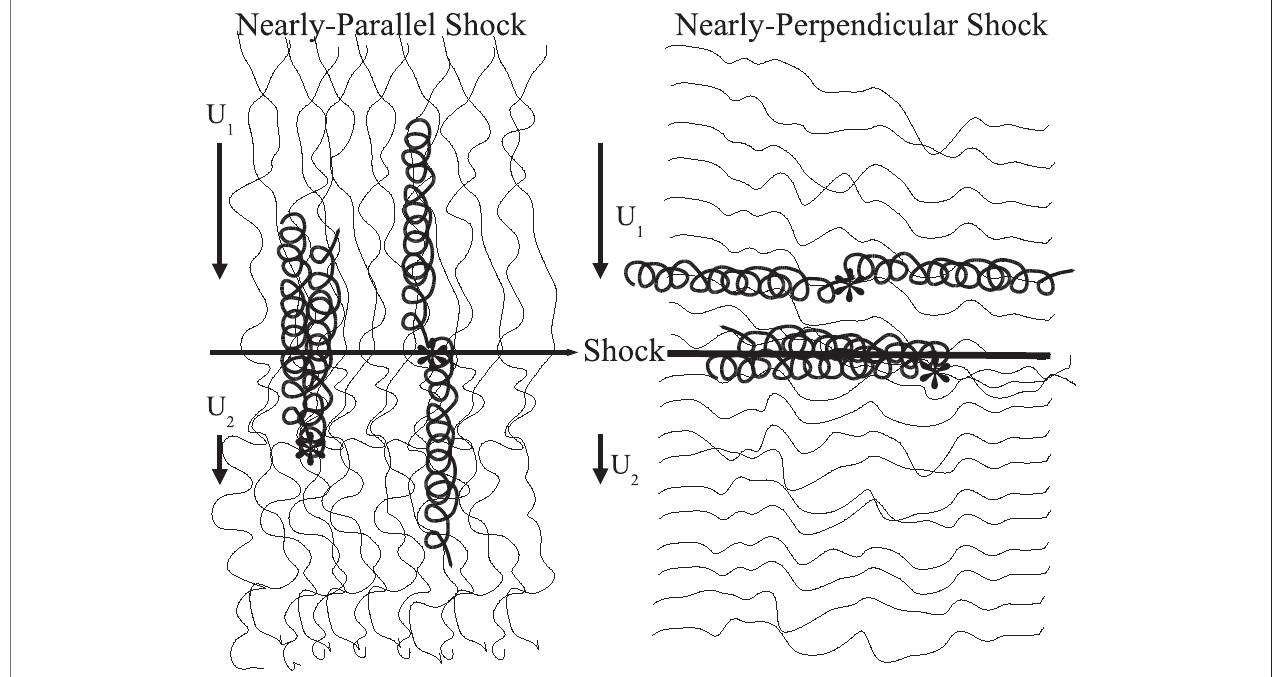
FIGURE 2 | Cartoon illustrating the difference in the acceleration of charged particles at parallel (left) and perpendicular (right) shocks. In the former, the particles can move back and forth across the shock moving along the magnetic fi eld, whereas in the latter, the particles cannot move as easily normal to the shock front and the energy gain at the shock comes in large part from drift. The electric fi eld is perpendicular to the magnetic fi eld and the fl ow velocity.